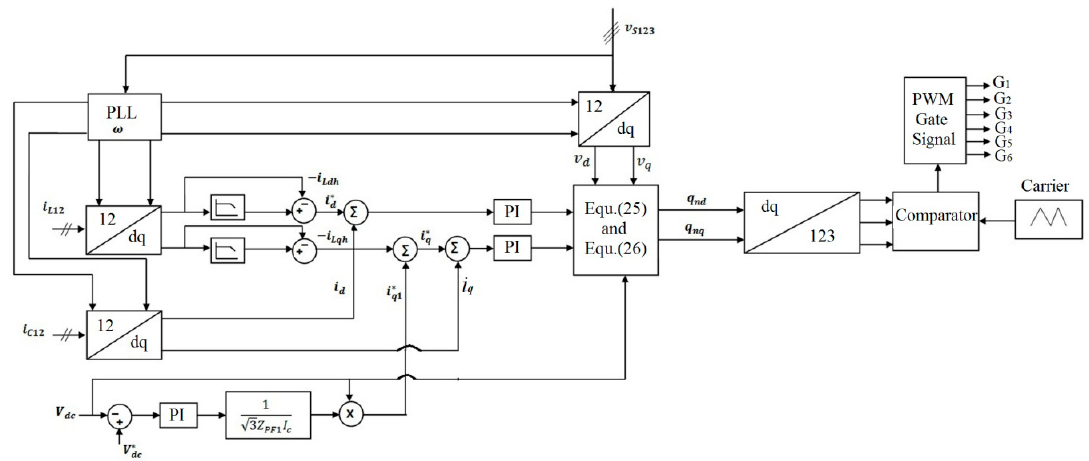
Figure 3. Control structure of the shunt hybrid compensator.